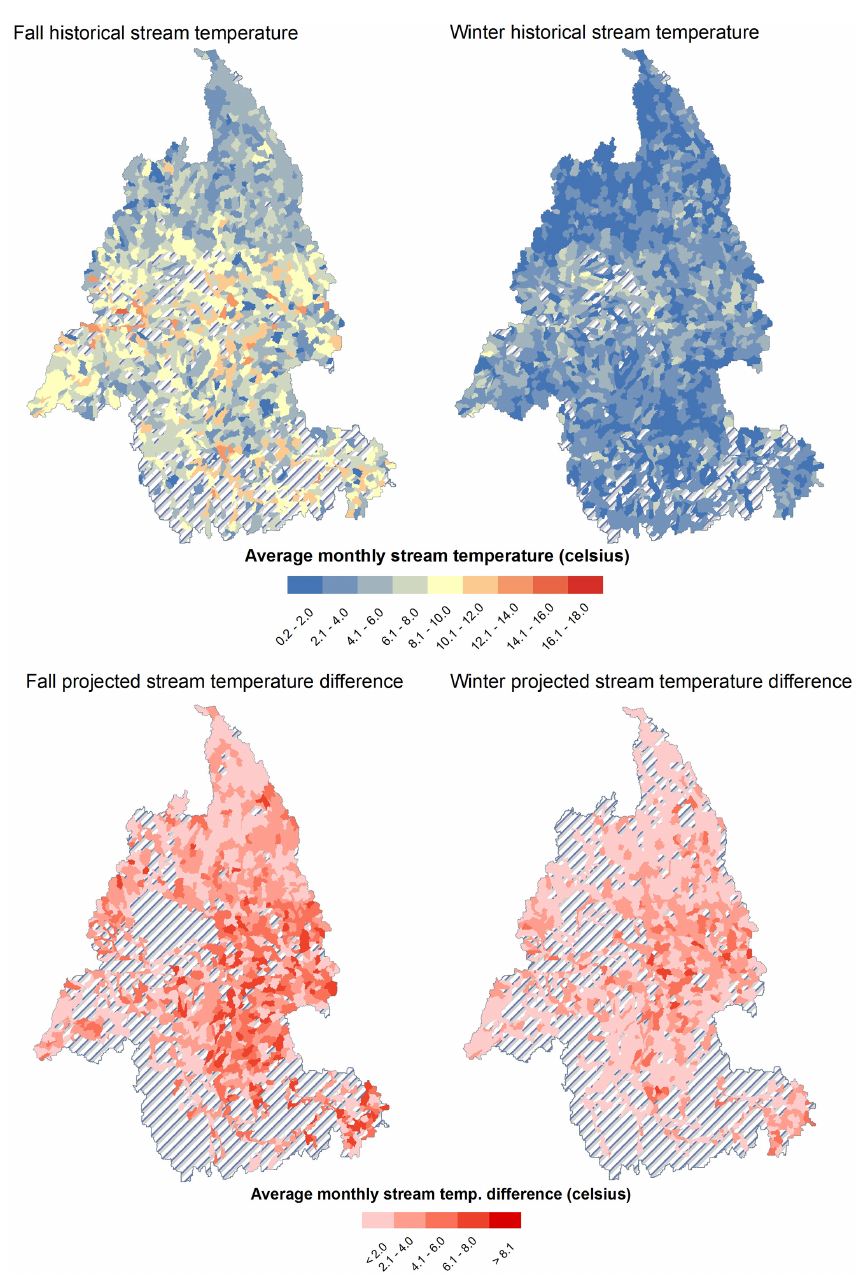
Figure 6. Fall and winter historical and projected stream temperatures at the subbasin level. Hatched subbasins indicate that drying occurred under climate projections and were removed from